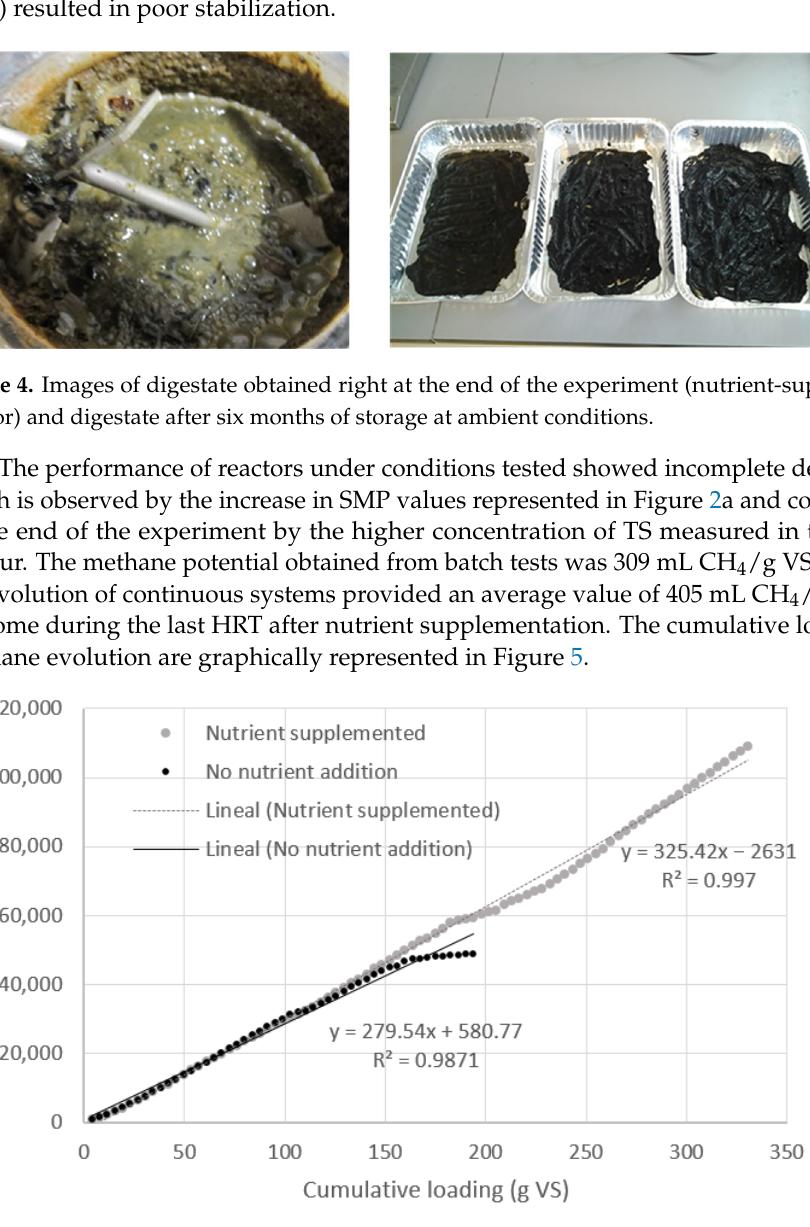
Figure 5. Cumulative evolution of methane production for semi-continuous operating reactors.